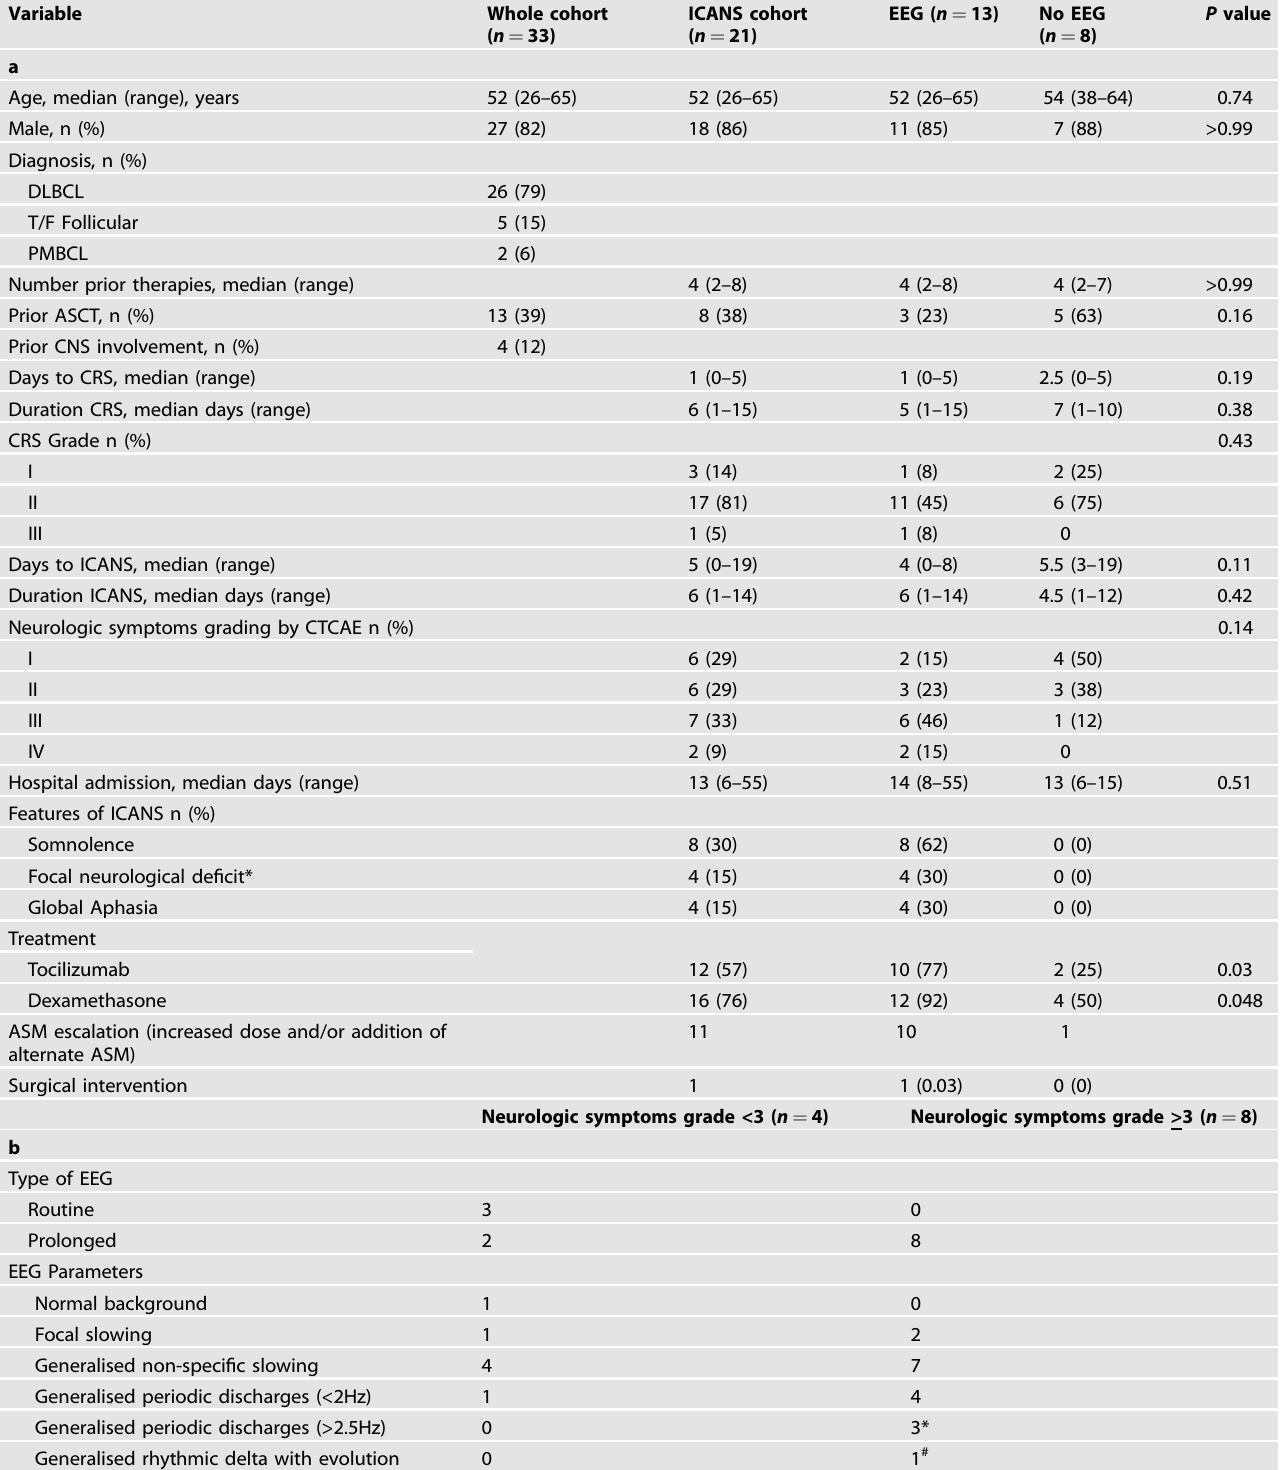
Table 1. a Characteristics of patients. b Summary of EEG